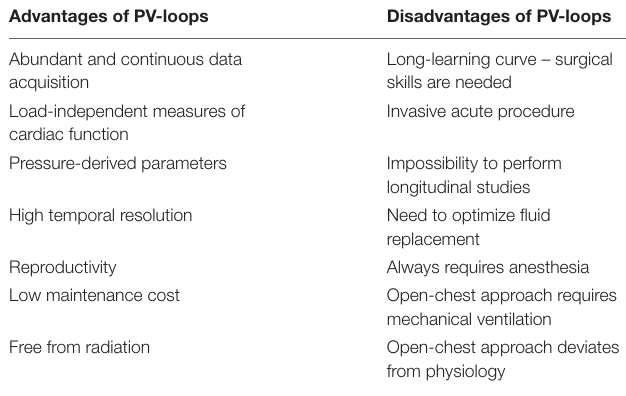
TABLE 2 | Main advantages and disadvantages of pressure-volume loop analysis to assess cardiac